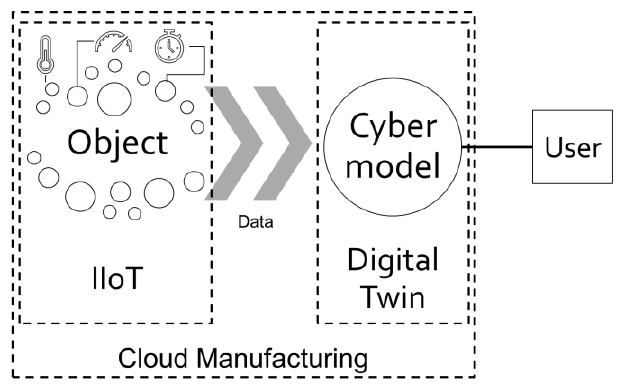
Figure 2. Digital twin data flow.